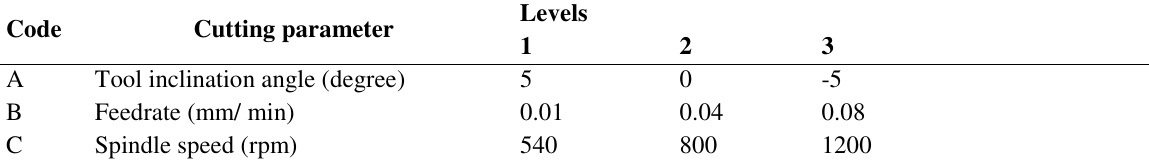
Machining variables and their levels